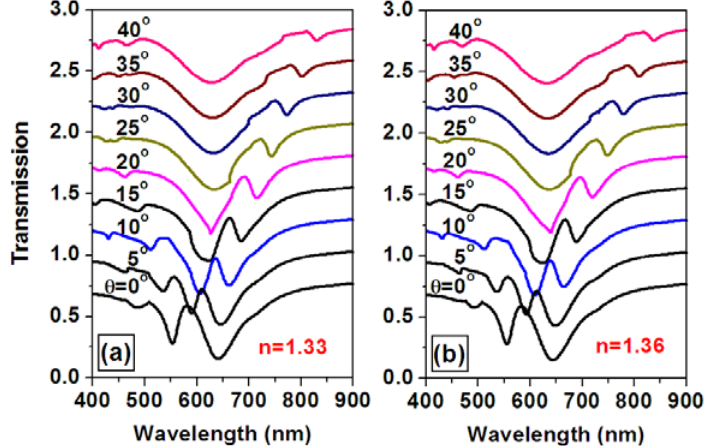
Figure 11. The simulation of the transmission spectra at different angles of incidence for an environmental refractive index of ( a ) 1.33 and ( b ) 1.36.